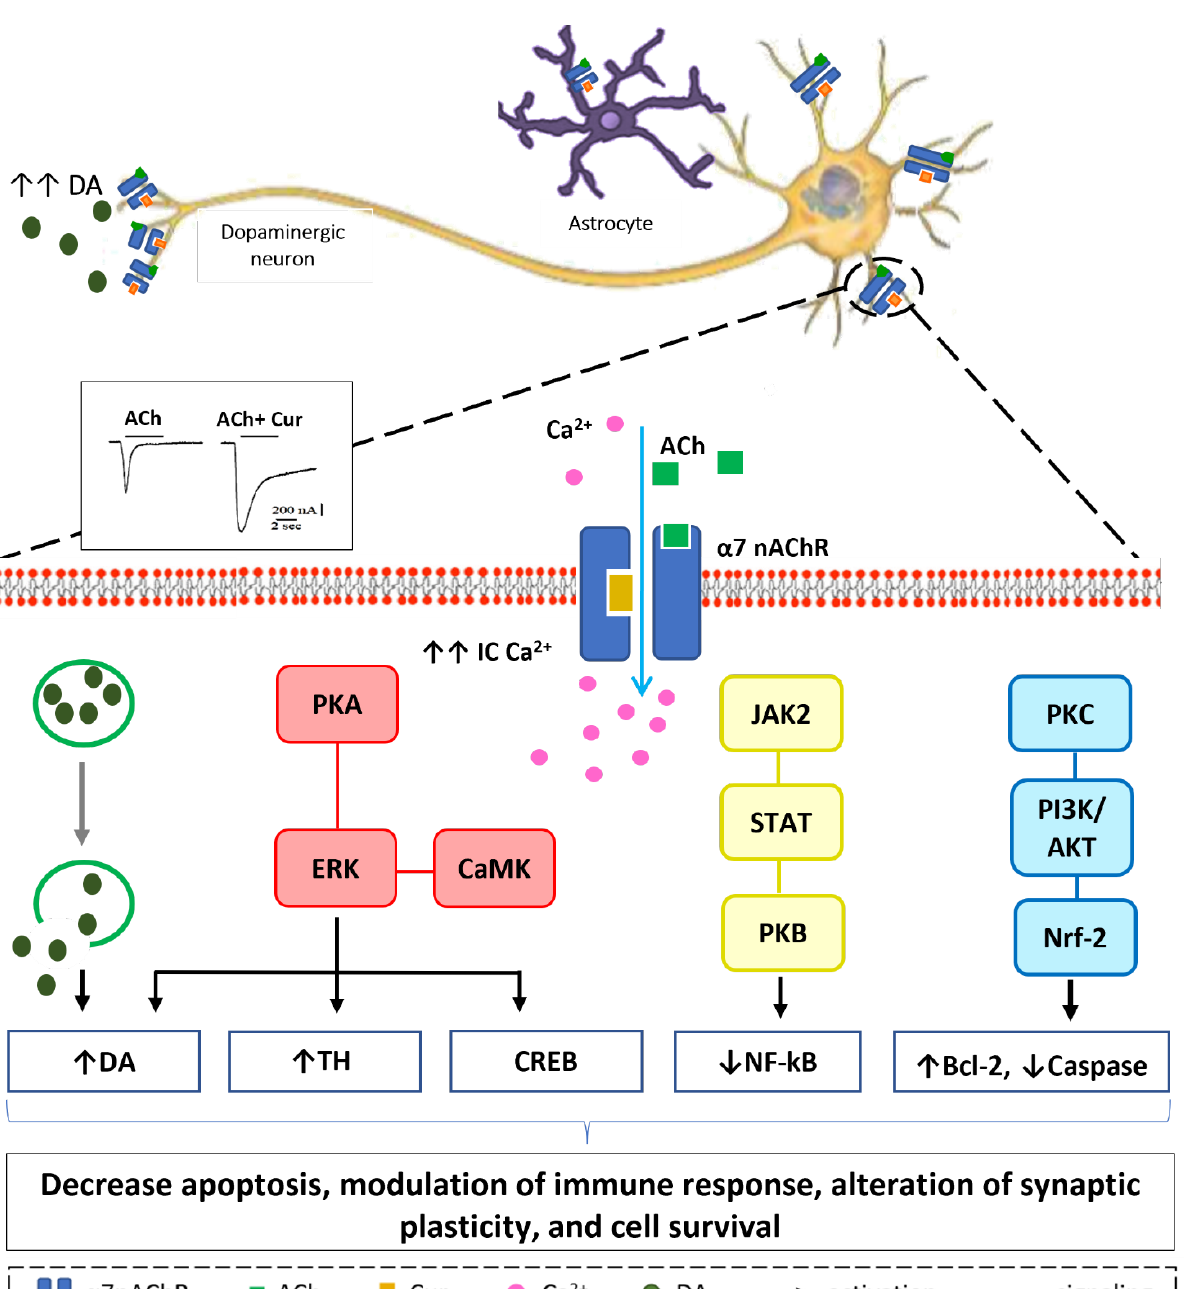
Figure 4. Hypothetical model of Ca 2+ -dependent cell survival mechanism. Curcumin modulate α 7-nAChR allosterically allowing more Ca 2+ entry into the cell as depicted from the electrophysiological recording. Increase in intracellular Ca 2+ concentration will lead to a cascade of events in dopaminergic neurons (from left to right): Facilitation of dopamine release from synaptic vesicles. Activation of ERK by PKA and/or CaMK, upregulate CREB protein, increase tyrosine hydroxylase activity, and activate dopamine release. JAK2/STAT3 signaling pathway leads to inhibition of NF-kB translocation via PKB activation. Increase in IC Ca 2+ attenuates inflammatory response in immune cells activating protein kinase C, PKC appears to activate downstream signaling PI3K/AKT pathways that promotes Nrf-2 translocation resulting in modulation of cell survival proteins; Bcl-2 and caspase.